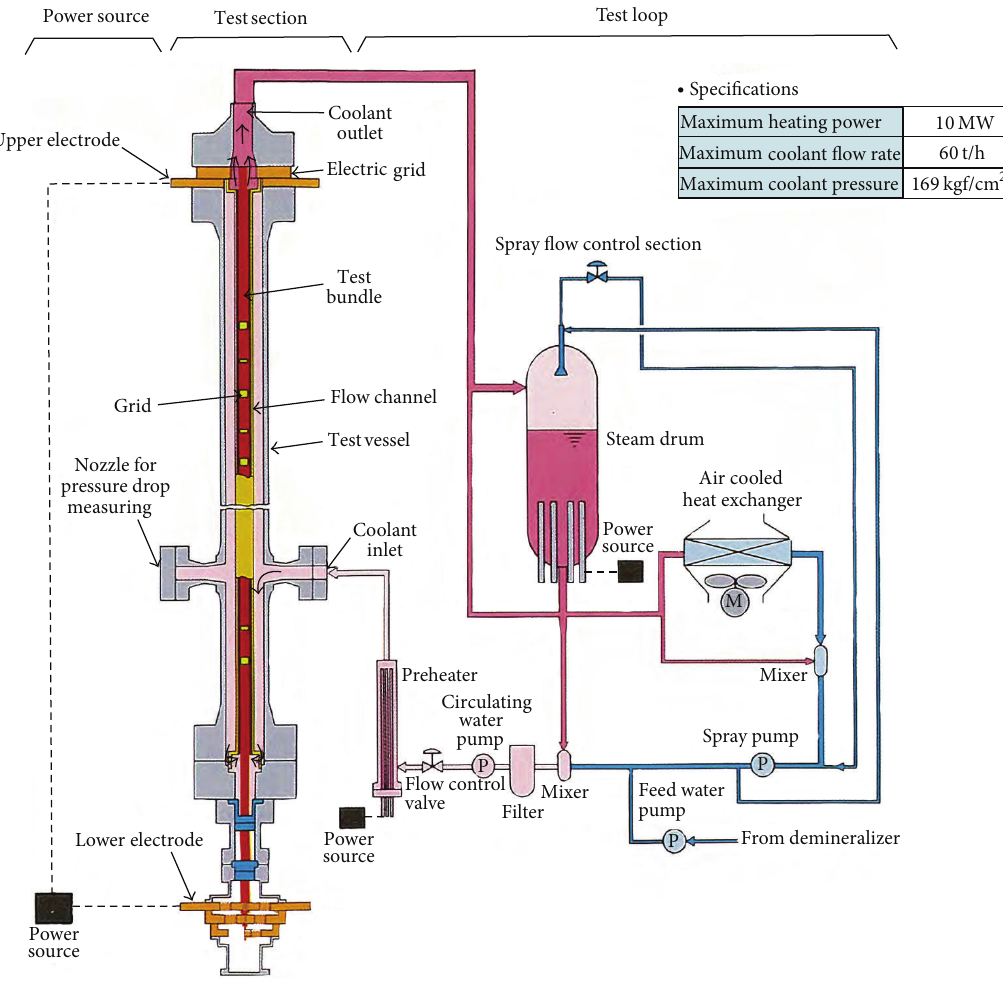
Figure 1: System diagram of NUPEC PWR test facility.